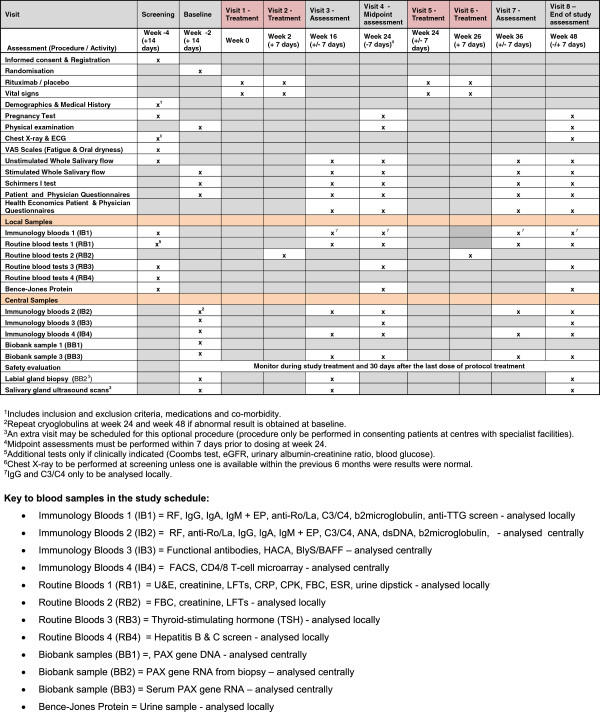
Schedule of events.